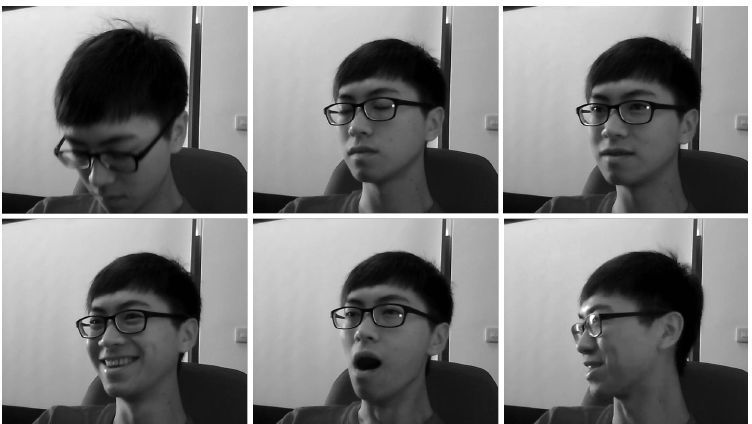
Figure 4. Sample images for different behaviors in similar